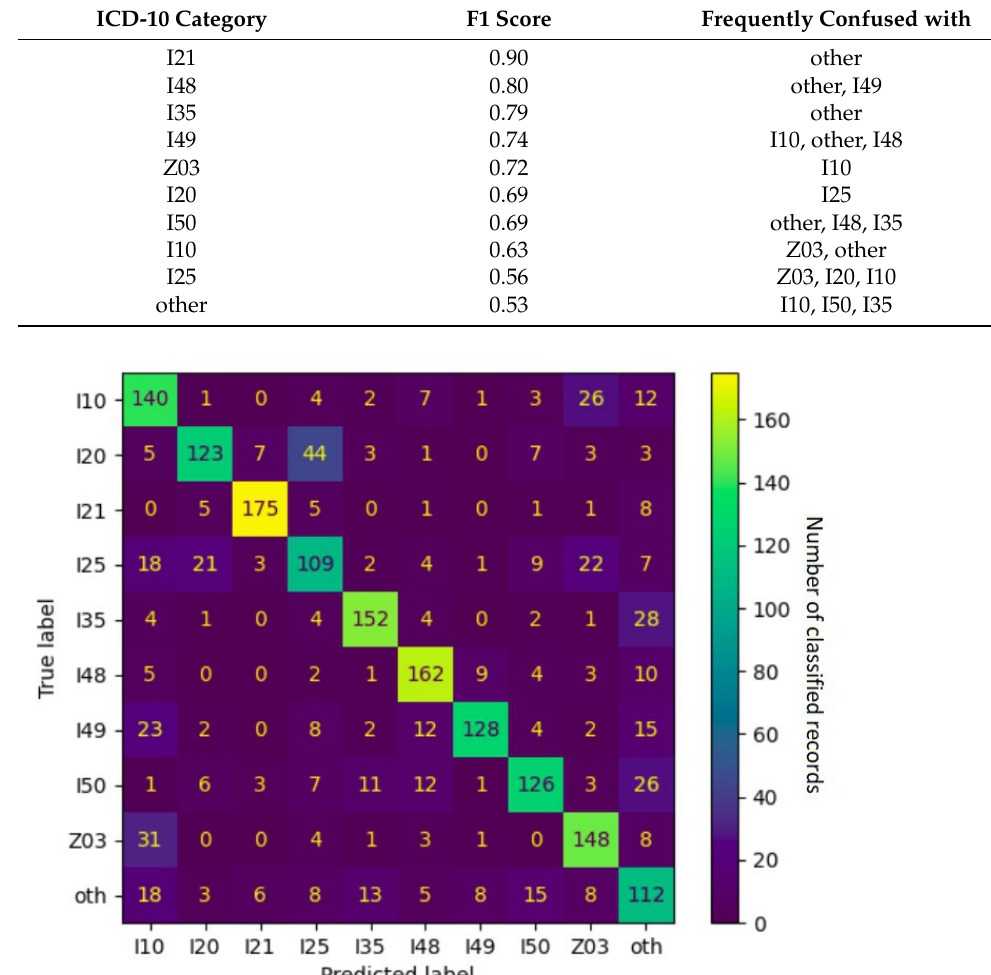
Table 6. Performance per category in a 9 + 1 setup fine-tuned on both admission and discharge data, sorted by F1 score, as a harmonic mean of precision and recall.